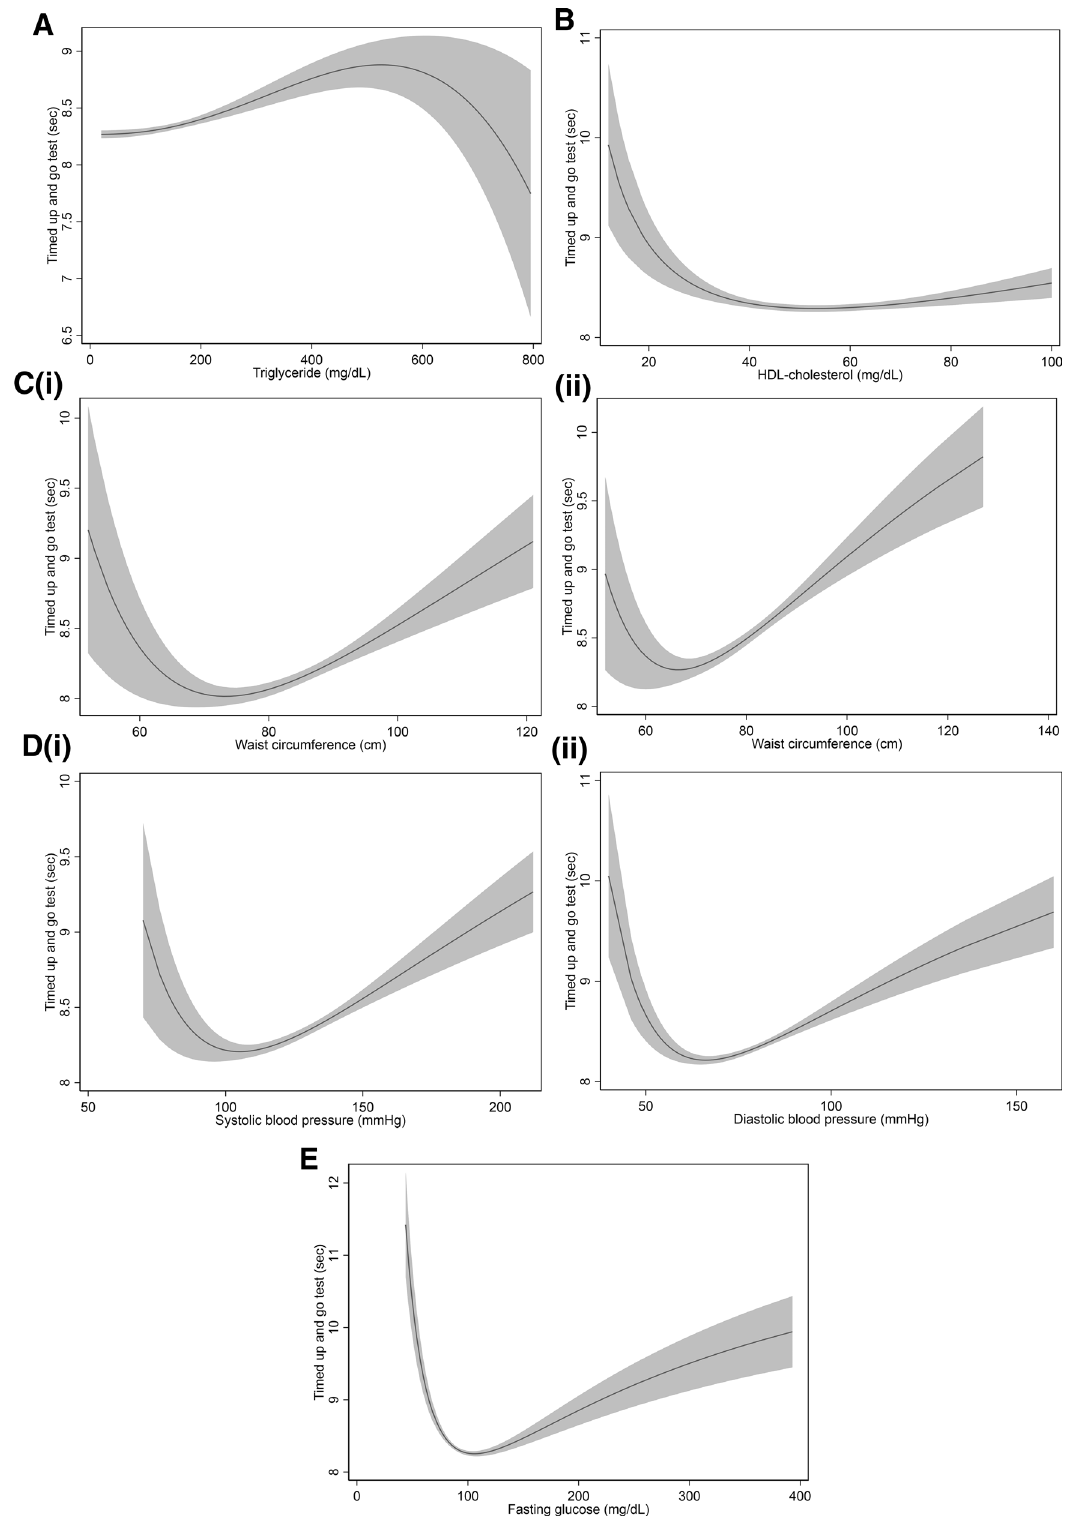
Figure 2. Association of Timed up and go test with features of metabolic syndrome, ( A ) TG, ( B ) HDL-C, ( C-i ) waist circumference of men, ( C-ii ) waist circumference of women, ( D-i ) systolic blood pressure, ( D-ii ) diastolic blood pressure, ( E ) fasting glucose. Gray area depicts 95% confidence